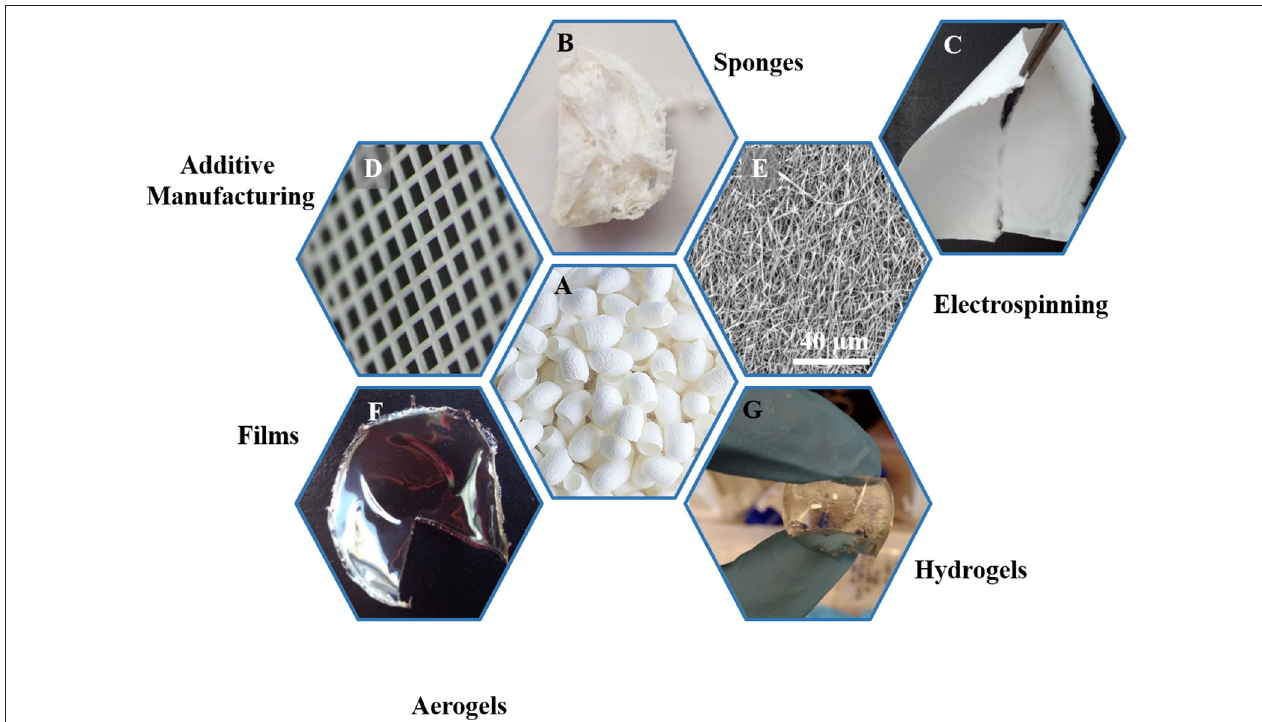
FIGURE 1 | Overview of the various biomaterials obtained from of silk fibroin extracted from silk cocoons (A) . Silk cocoons (A) , sponges (B) , macroscopic and microscopic images of electrospun mats (C,E) , 3D printed structures (D) , films (F) , hydrogels (G) , and aerogels (H)